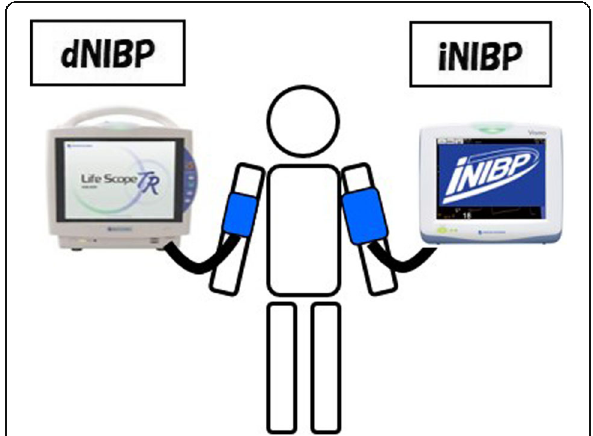
Fig. 1 Blood pressure measurement. iNIBP cuff was wrapped around the same arm as the intravenous line and dNIBP cuff was wrapped around the other arm